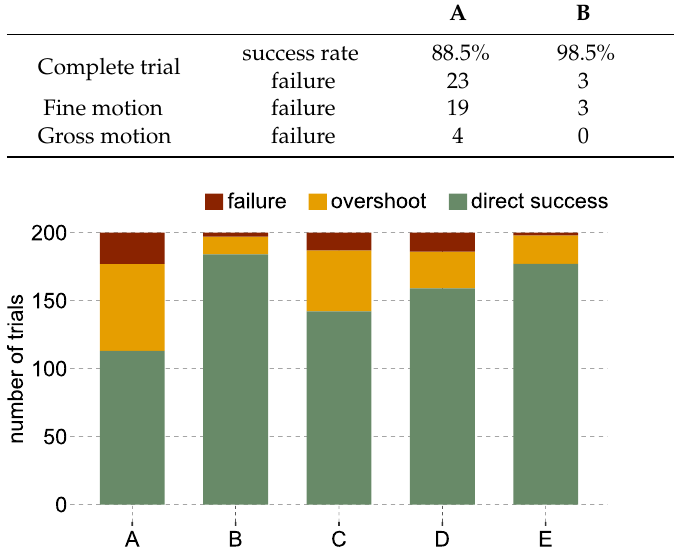
Figure 4. Overshoots over the whole experiment. For each labeling method A–E, the bar plot illustrates how often the trials were finished directly by moving the cursor straight into the target circle (green), a target was overshot before finishing the trial (orange), or the trials failed